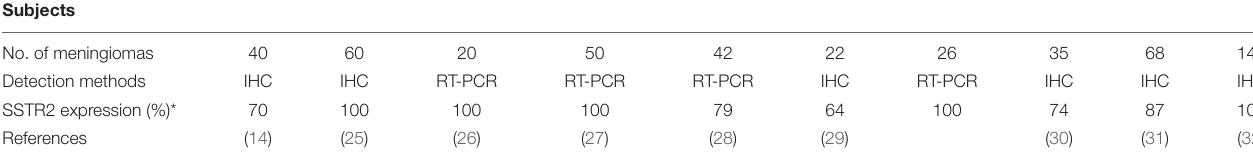
TABLE 1 | Studies regarding the detection methods and expression of SSTR2 in meningiomas.